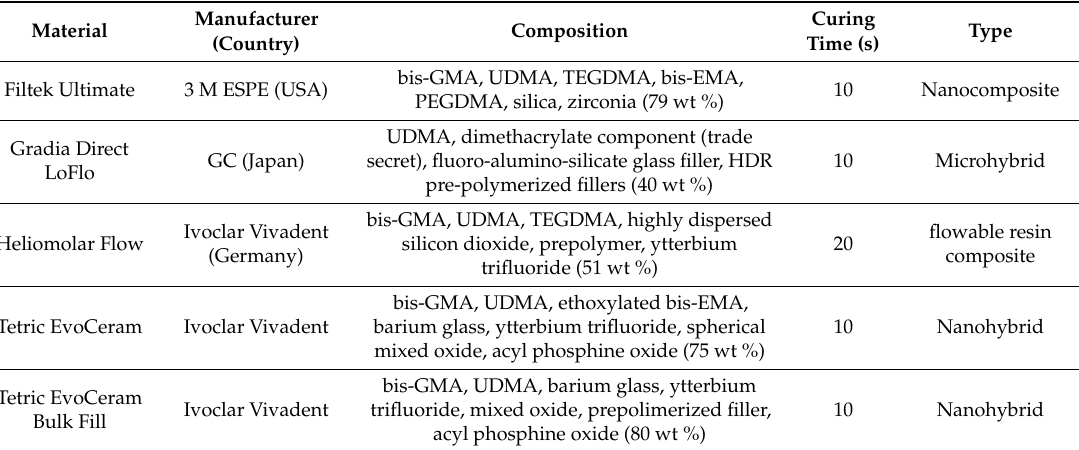
Table 2. The composition of investigated